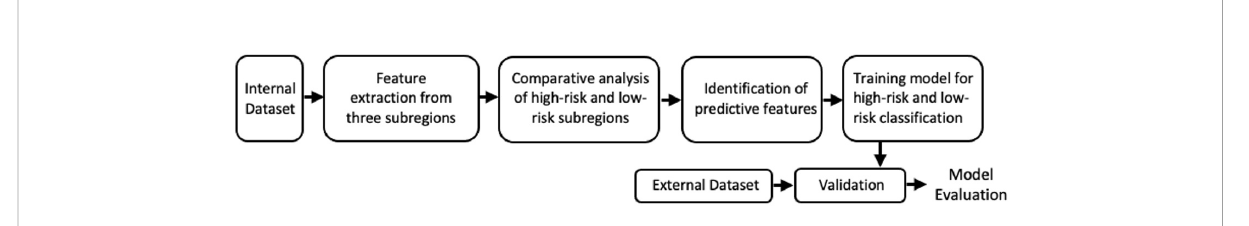
FIGURE 3 The major steps performed in the analysis and prediction